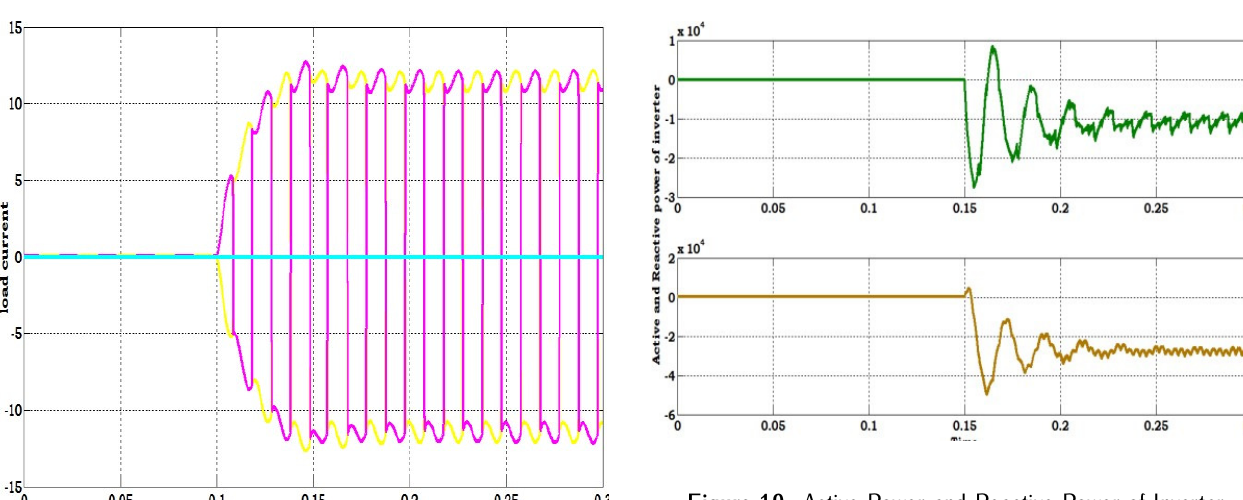
Figure 19. Active Power and Reactive Power of Inverter